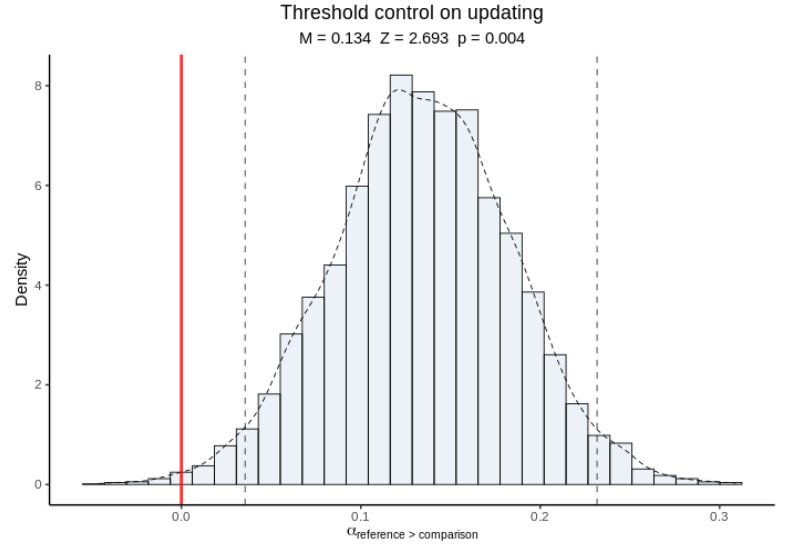
Figure 9. Posterior inference on hyper-mean thresholds in reference versus comparison trials. Raised thresholds in reference trials suggest cognitive control in response to the updating